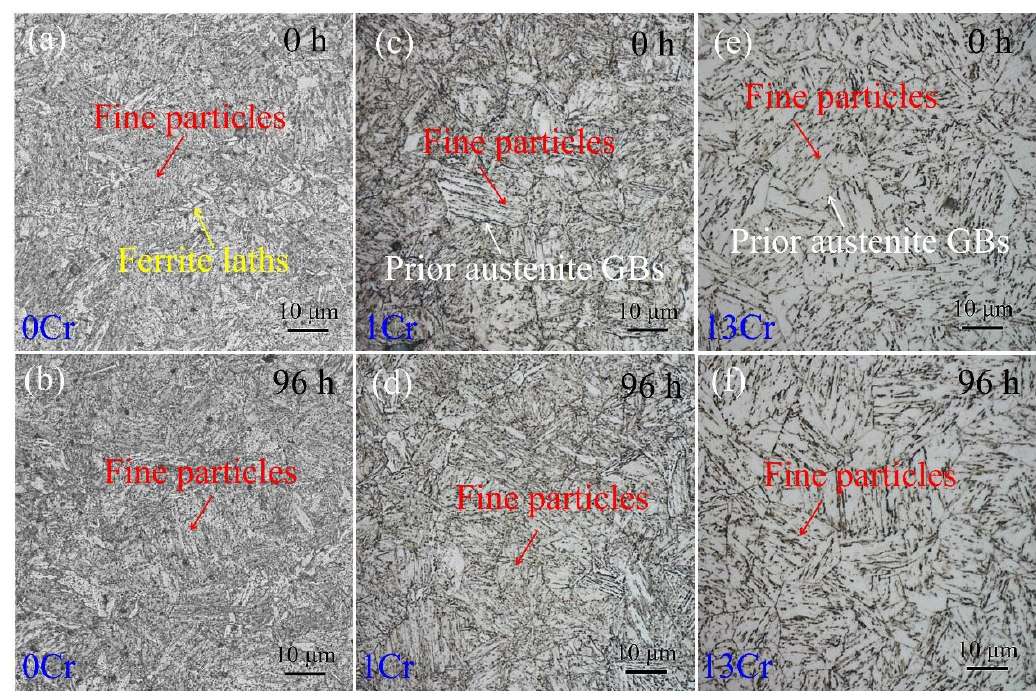
Figure 3. Optical morphologies of three types of samples after creeping for various times: ( a , b ) 0Cr samples; ( c , d ) 1Cr samples; and ( e , f ) 13Cr samples. ( a , c , e ) Creep-free samples; ( b , d , f ) samples crept for 96 h.